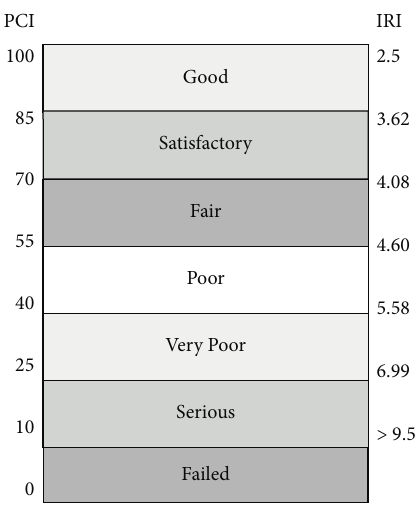
Figure 6: Pavement quality for given IRI and PCI values based on Shahin’s PCI classification [2].